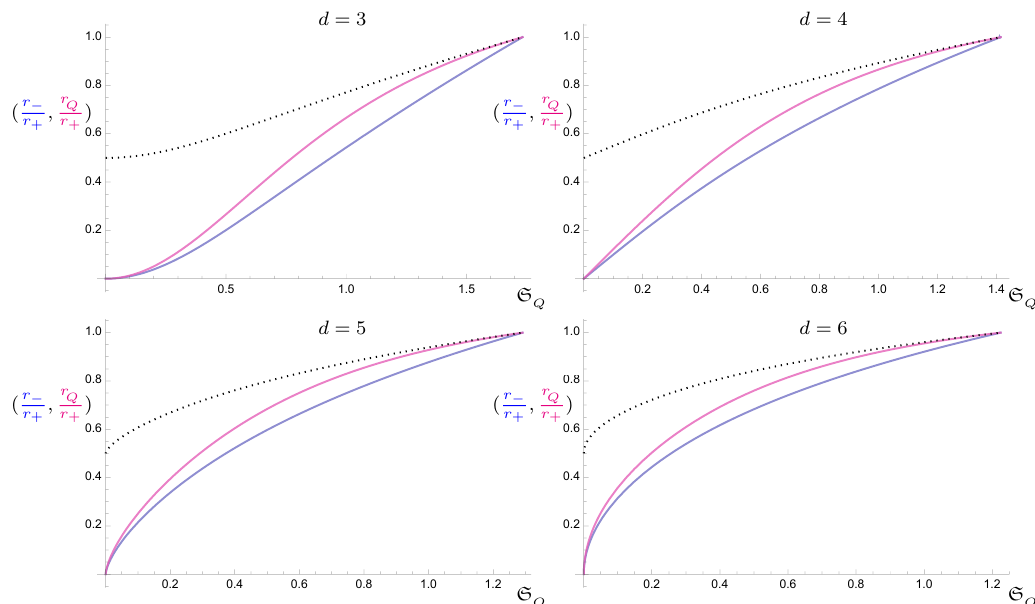
(magenta), normalized Q which is our proxy for the charge. Q (dotted curves) to illustrate that r approaches this value 2 Q